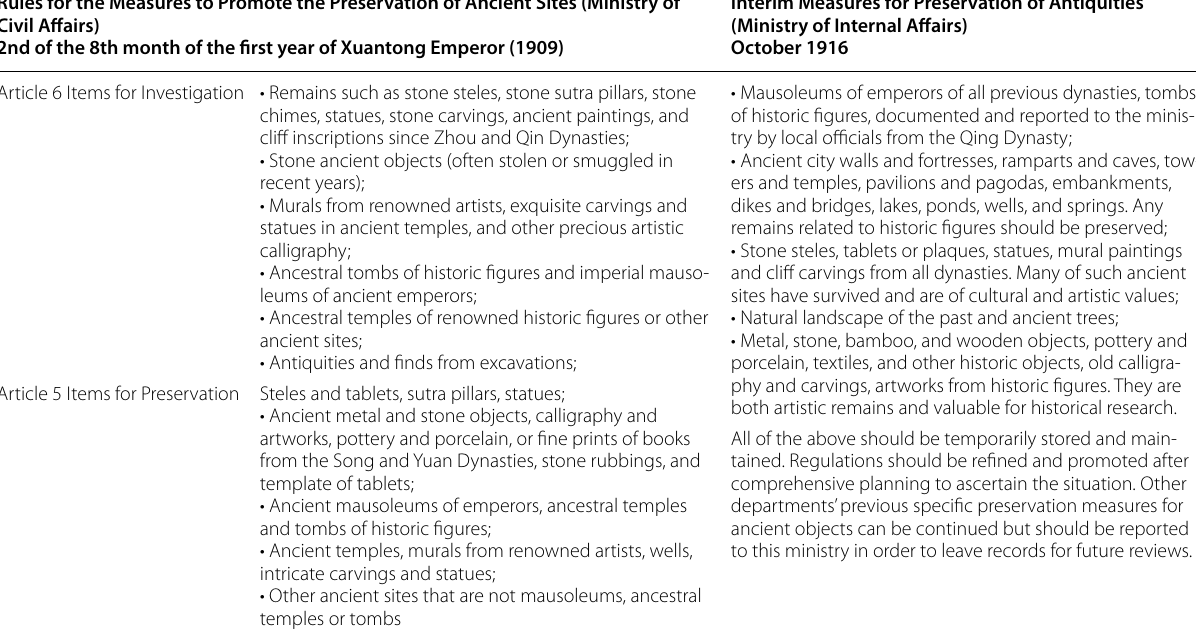
Table 1 Comparison of two legal documents from the late Qing Dynasty and early ROC era Rules for the Measures to Promote the Preservation of Ancient Sites (Ministry of Civil Affairs) 2nd of the 8th month of the first year of Xuantong Emperor